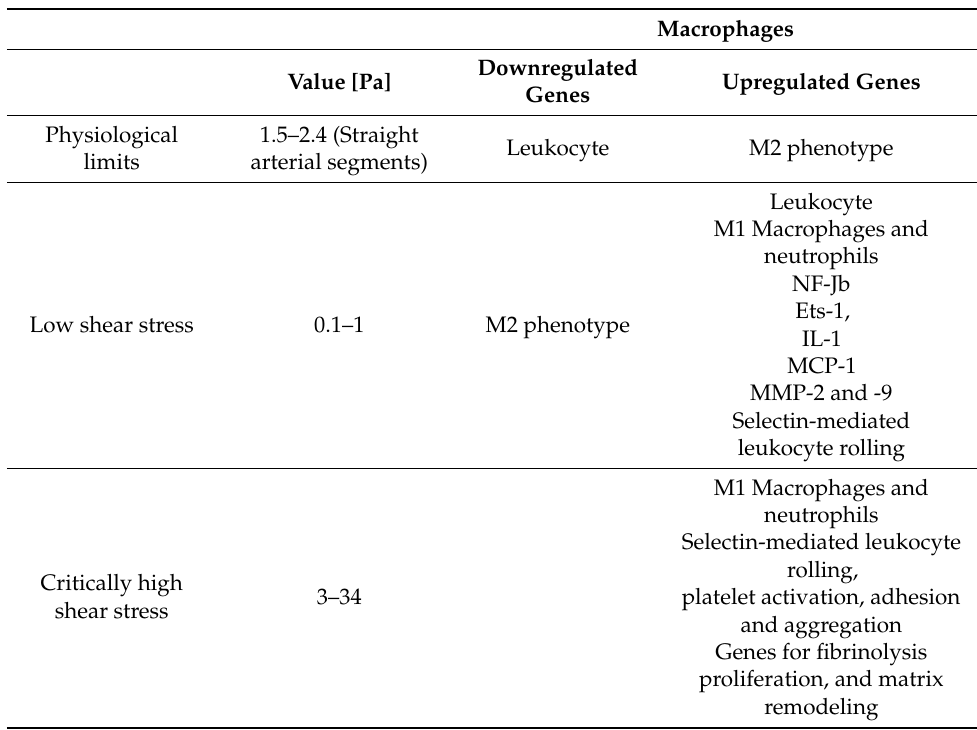
Table 1. Effect of baseline, low and critically high shear stress on macrophage and inflammation resolution according to the literature [47,51,56]. Macrophages Value [Pa]